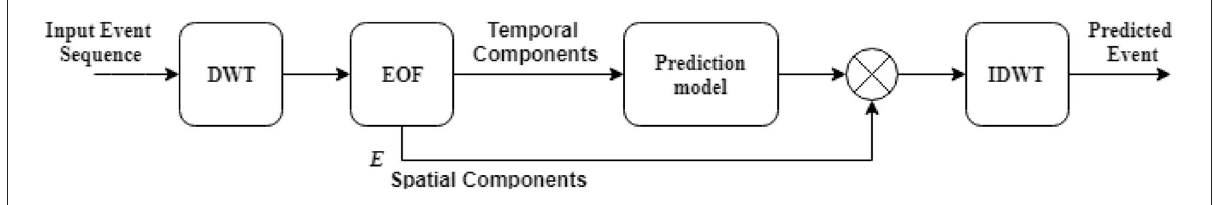
FIGURE1 Block diagram of the proposed WELL model. DWT stands for Discrete Wavelet Transform, EOF for Empirical Orthogonal Function, and IDWT for Inverse DWT.